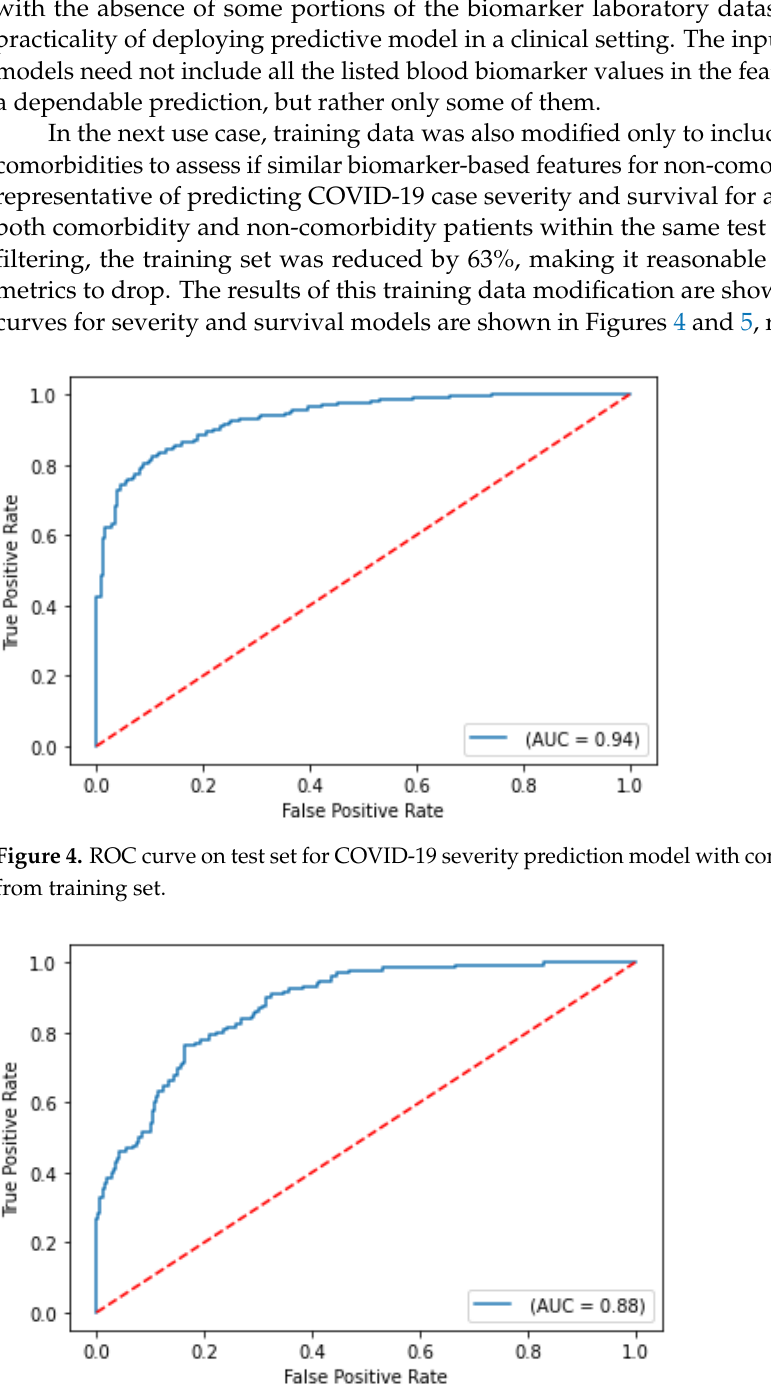
Figure 5. ROC curve on the test set for COVID-19 survival prediction model with comorbidities removed from the training set.